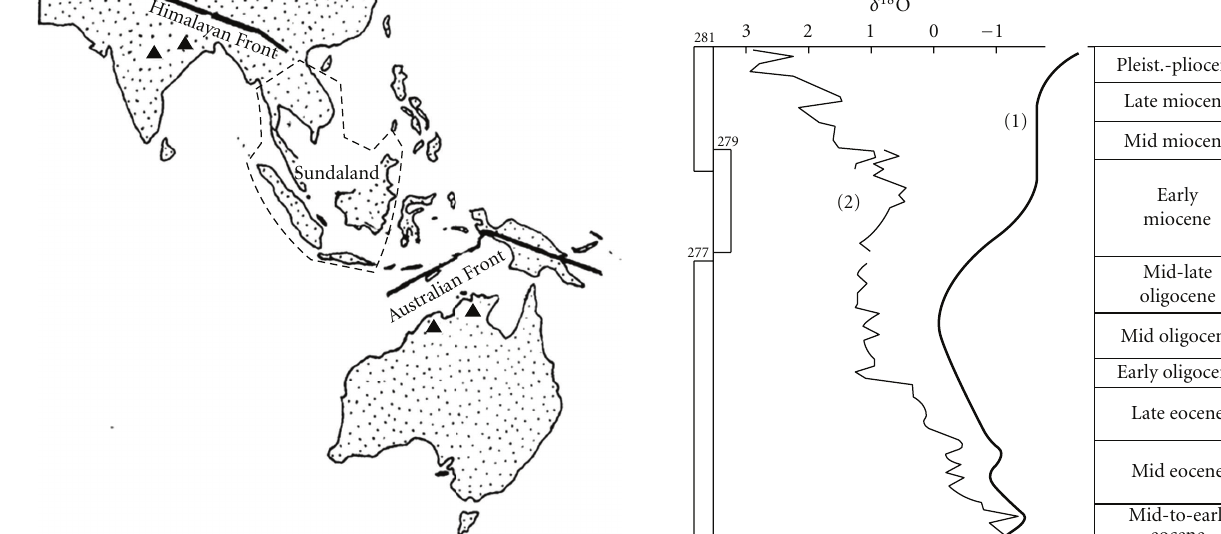
Figure 2: Some (14%) of the flora that has been recorded on the sandstone outcrops ( (cid:2) ) in northern Australia has also been found in the sandstone hills of eastern India ([37], see [5, Figure 5.8]). The Fronts of the Australian and Himalayan Tectonic Plates are shown by solid lines; the extent of the Sundaland Platelet is shown by a broken line.